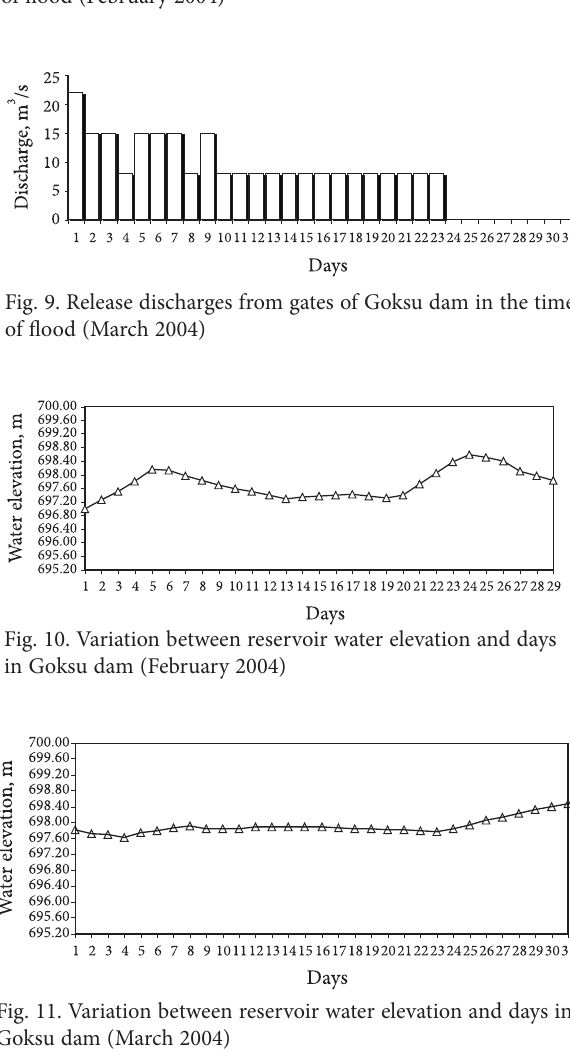
Fig. 8. Release discharges from gates of Goksu dam in the time of flood (February 2004)